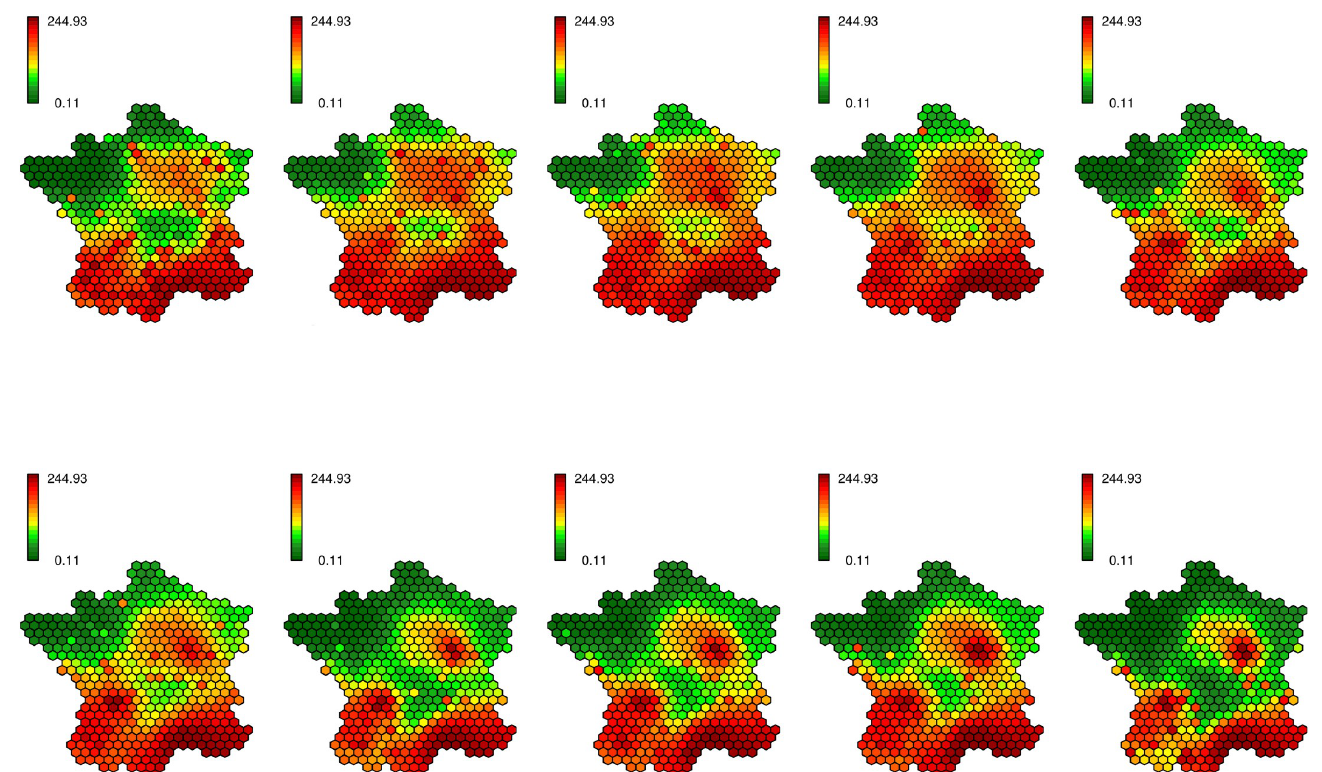
Fig 9. Estimated risk for the bovine tuberculosis (model nebinnopar_S_x_ST_xxxx ).